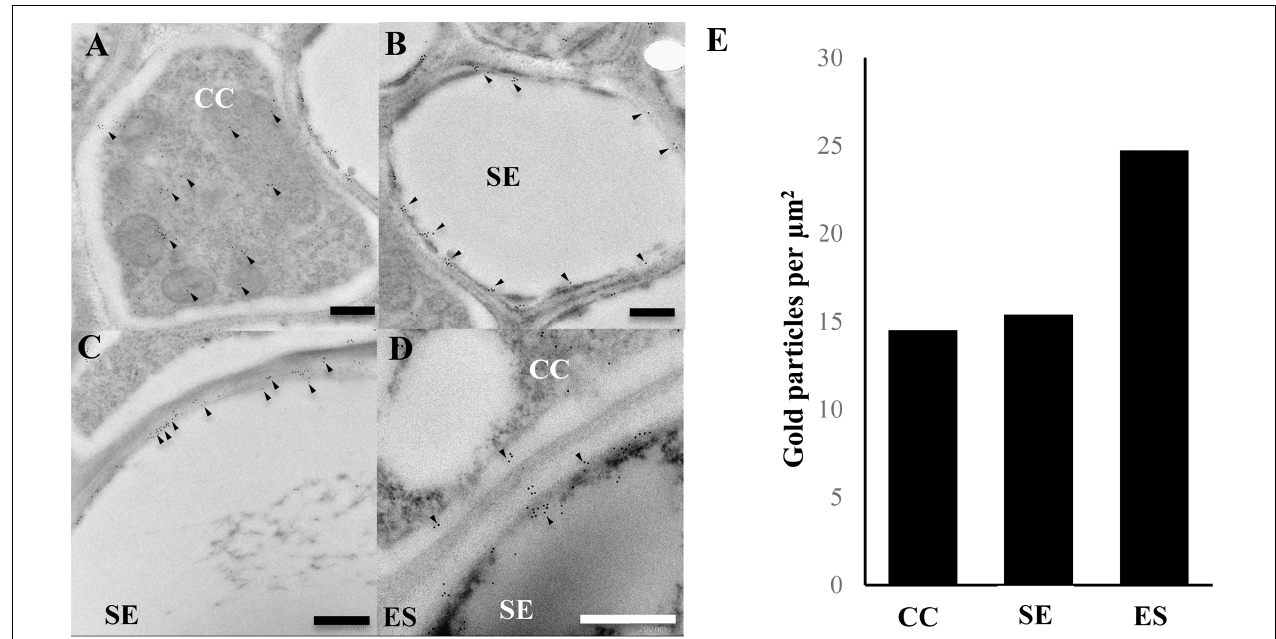
FIGURE 2 | Immunogold localisation of AtACBP3 using anti-AtACBP3 antibodies in transmission electron microscopy of cross sections of apical stems from 5-week-old Arabidopsis. (A) Companion cell. (B) Sieve element. (C,D) Extracellular space. (E) Densities of gold particles were quantified per µ m 2 . Arrowheads indicate gold particles. Multiple floral stems from different individual plants sectioned and analysed in this experiment showed consistent results. Further images are available in Supplementary IEM Images. CC, companion cell; ES, extracellular space; SE, sieve element. Scale bar = 0.5 µ m.